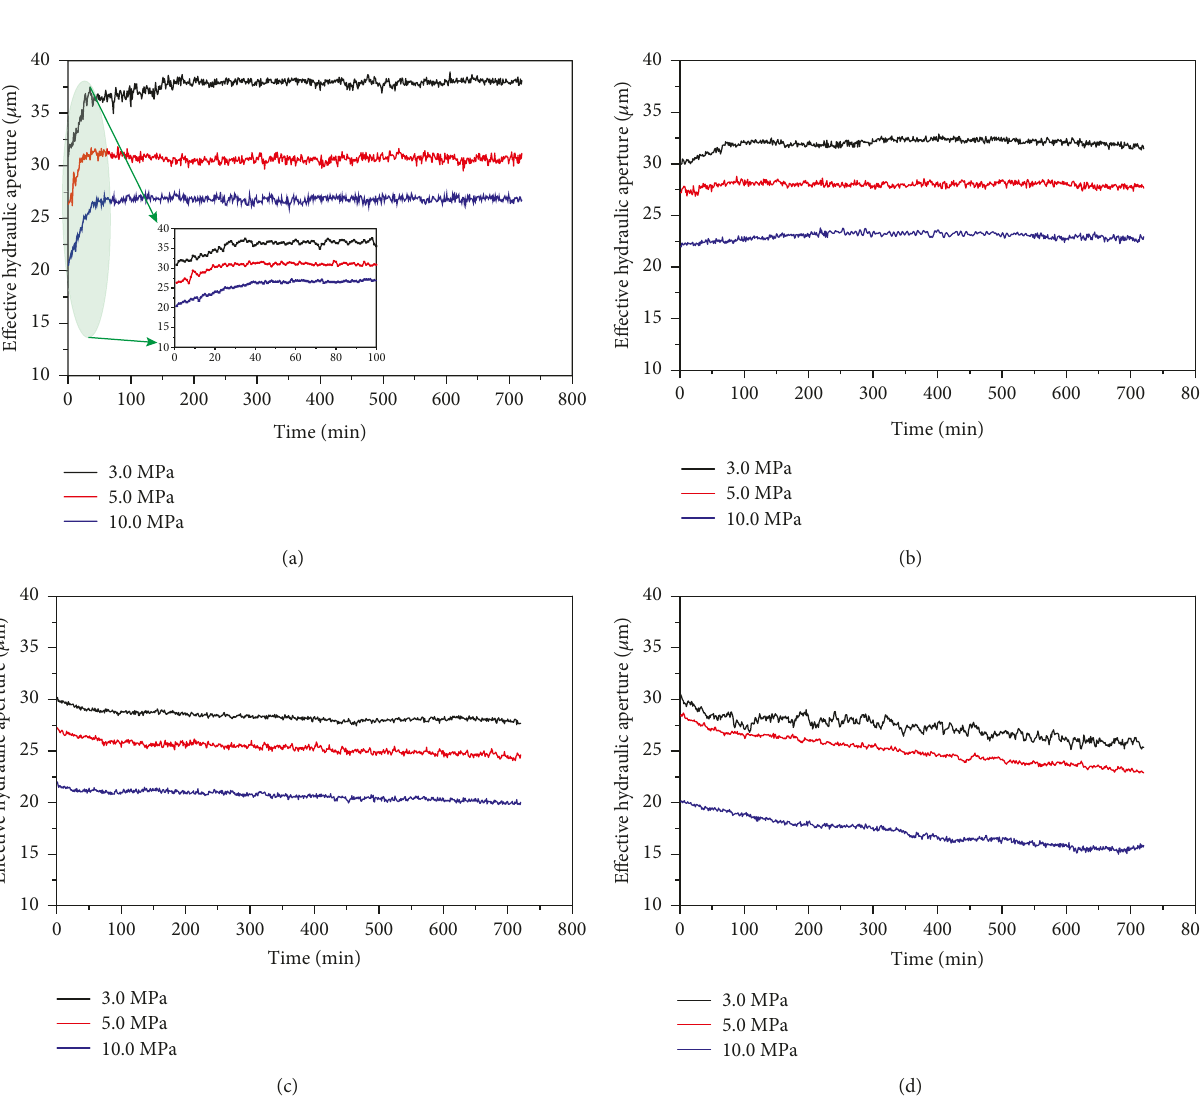
Figure 4: E ff ective hydraulic aperture evolution with time under di ff erent con fi ning stresses for Longmaxi shale. (a) Fluid pH =4.0 condition and the subplot is an expanded fi gure during the period of e ff ective hydraulic aperture increase, (b) fl uid pH =5.0, (c) fl uid pH =6.0, and (d) fl uid pH =7.0. A monotonic increase in e ff ective hydraulic aperture until a maximum aperture is observed for fl uid pH =4.0 and 5.0 condition. Following this, the fracture aperture has a relatively small change. Sustained decrease of e ff ective hydraulic aperture is observed during the 12-hour core fl ooding experiments when fl uid pH =6.0 and